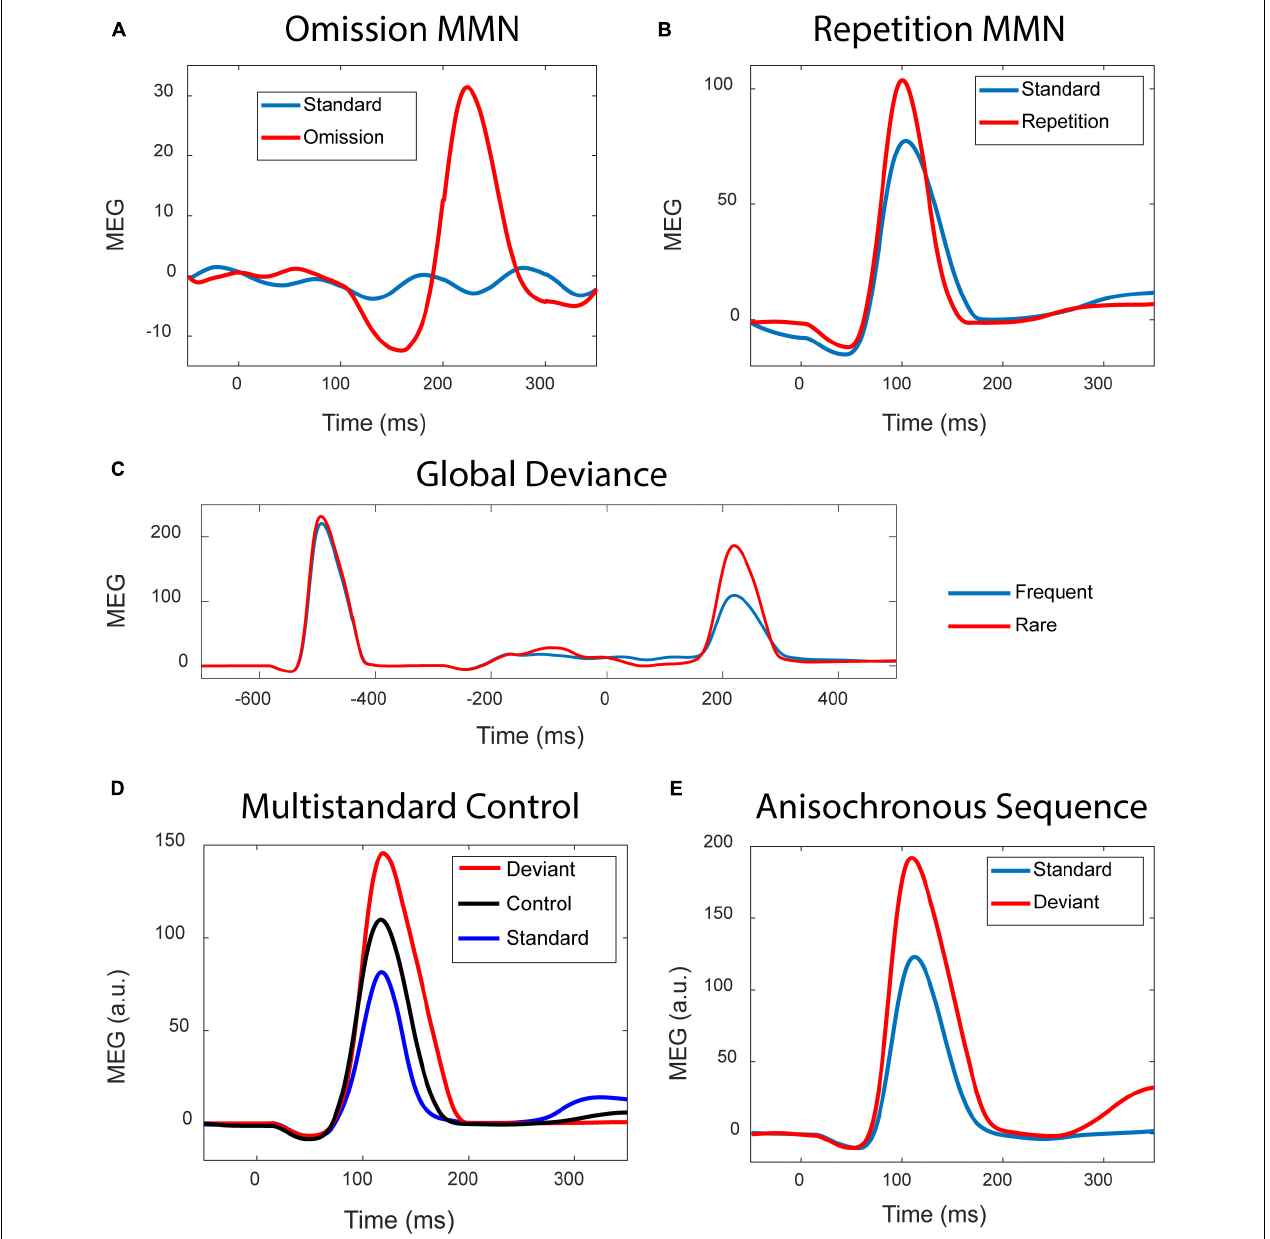
FIGURE 2 | Simulation results. (A) Standard stimuli presented at a fast rate (blue curve) elicit no discernible response, whereas the occasional stimulus omission (red curve) results in a prominent MMN. (B) Occasionally repeating a tone (red) in a sequence of alternating tones (blue) results in an MMN. (C) The blue curve is the response to a sequence xxxxX of five tones presented as a global standard, and the red curve is the response elicited by the same xxxxX as an infrequent global deviant. When the sequence is a global deviant, the ending of the sequence elicits a much stronger response than when it is a global standard. Zero time indicates the onset of the fifth tone. (D) In the classic oddball paradigm, frequency deviants (red) elicit a stronger response than the standards (blue). The response to the deviants is also stronger than the response elicited by the same deviants when these are presented as part of a random sequence of tones, in the so-called multi-standard control condition (black). (E) Standards (blue) and deviants (red) were presented as a series of anisochronous stimuli where the SOI varied